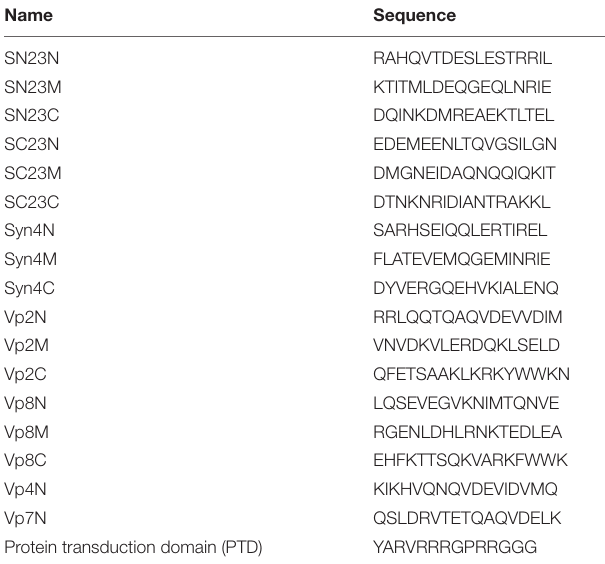
Table 1 | Amino acid sequences of synthetic peptides derived from mast cell soluble N -ethylmaleimide-sensitive factor attachment protein receptor (SNARE)